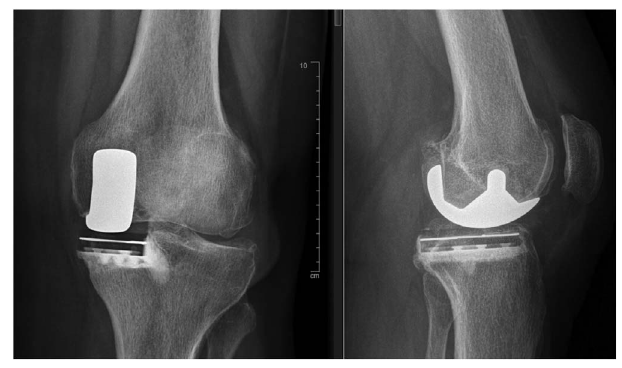
Figure 2. Medial HLS Uni Evolution ™ UKA (AP view and pro fi le).